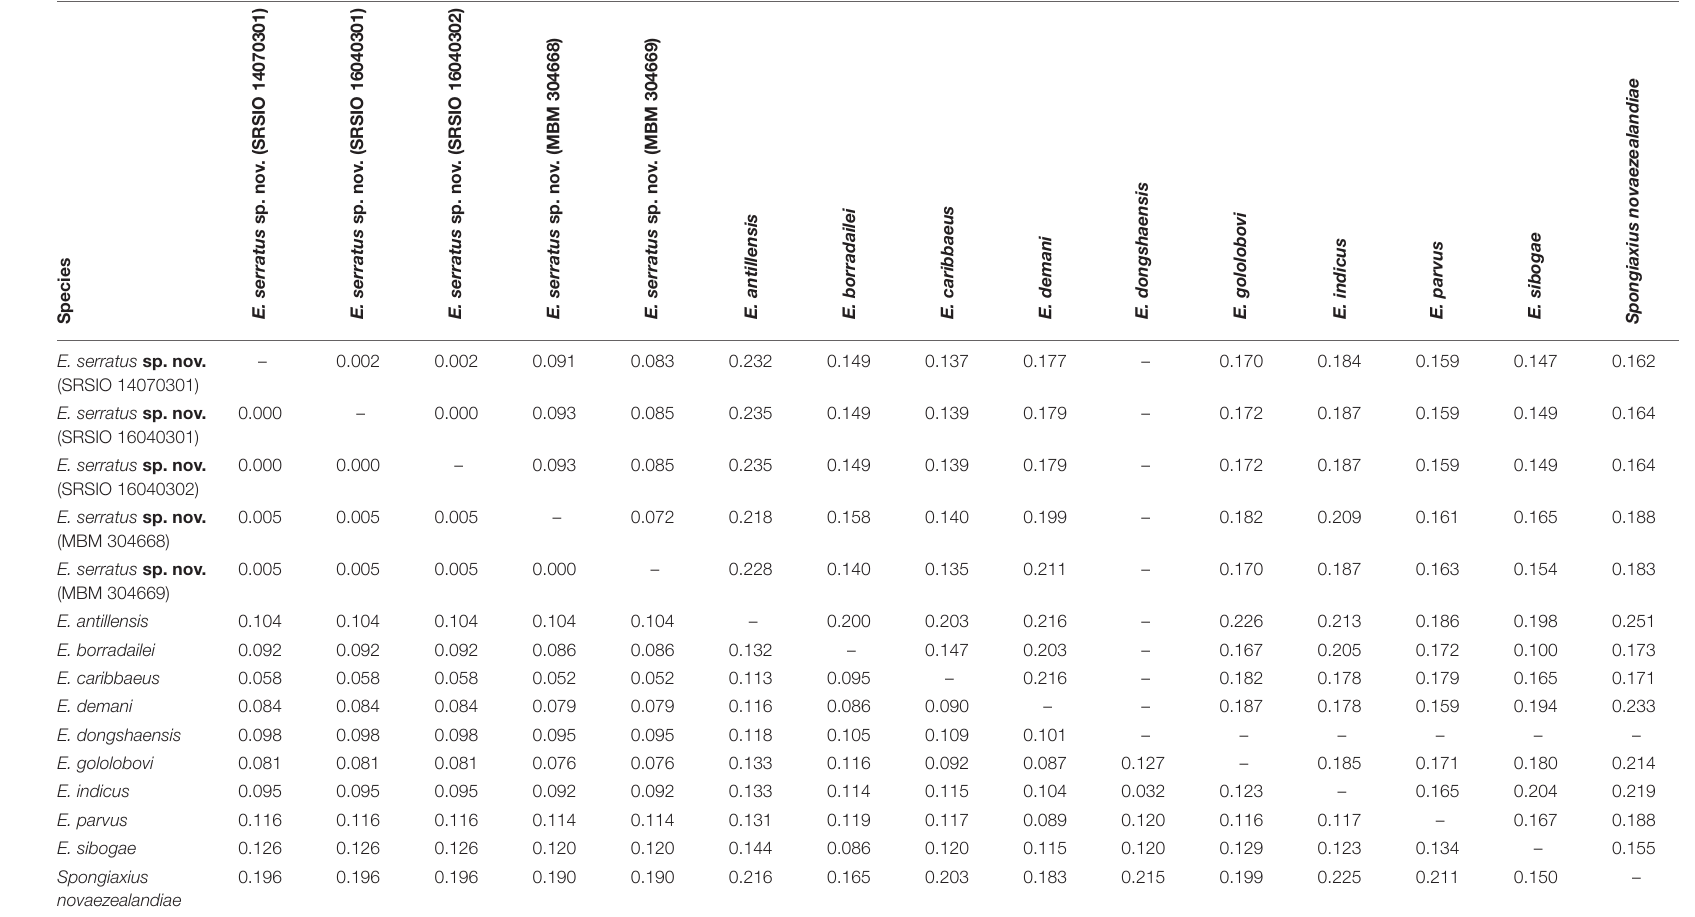
TABLE 2 | Kimura’s 2-parameter pair-wise genetic distances of 16S rRNA (below diagonal) and COI (above diagonal) gene sequences among species studied.